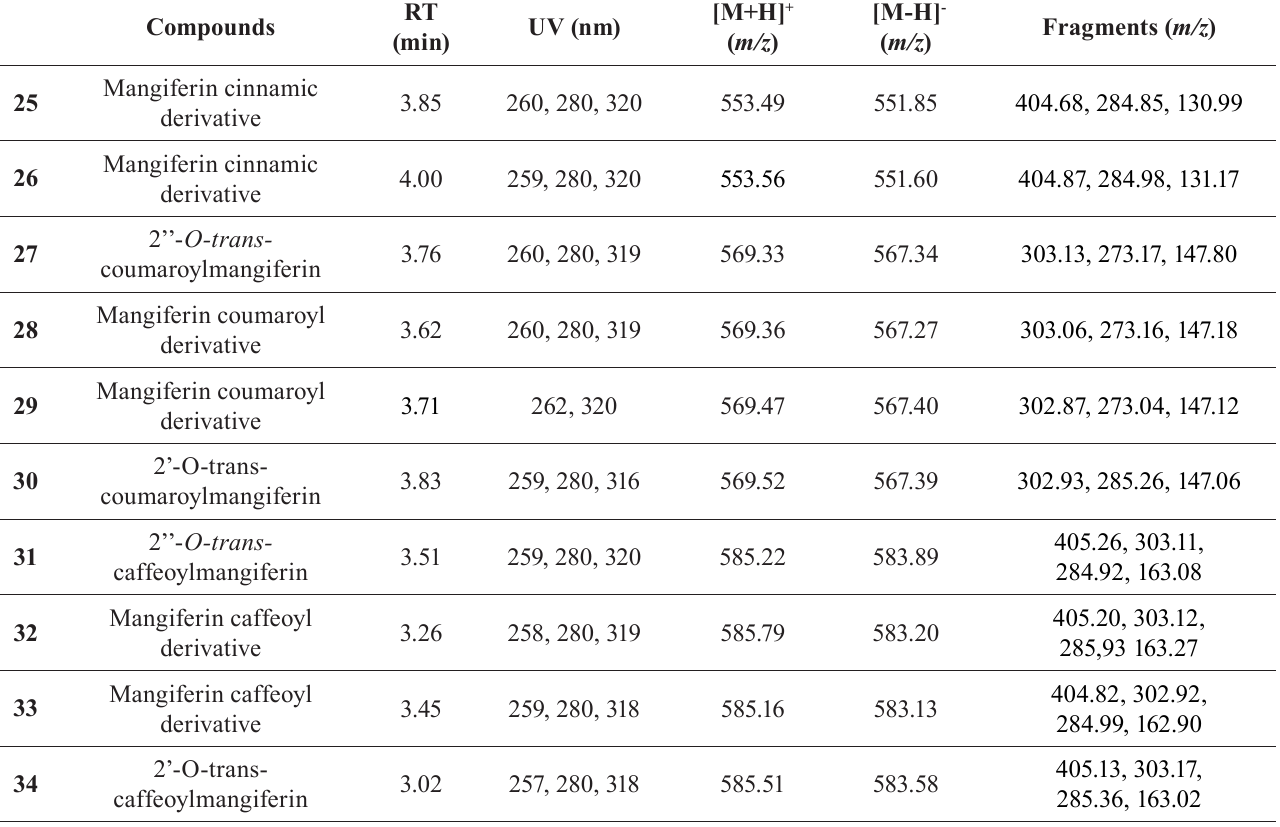
TABLE II - Xanthones identified in ethanolic extract of leaves from the Fridericia samydoides negative ion mode